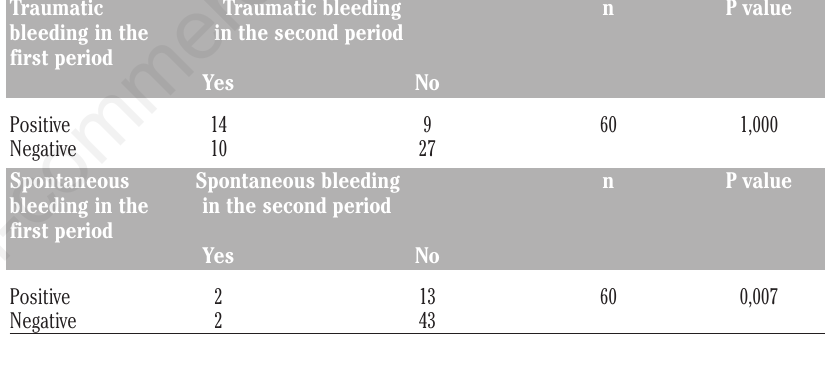
Table 5b. Bivariate analysis of traumatic bleeding and spontaneous: standard comprehen- sive treatment program vs personalized pharmacokinetic-based treatment program.